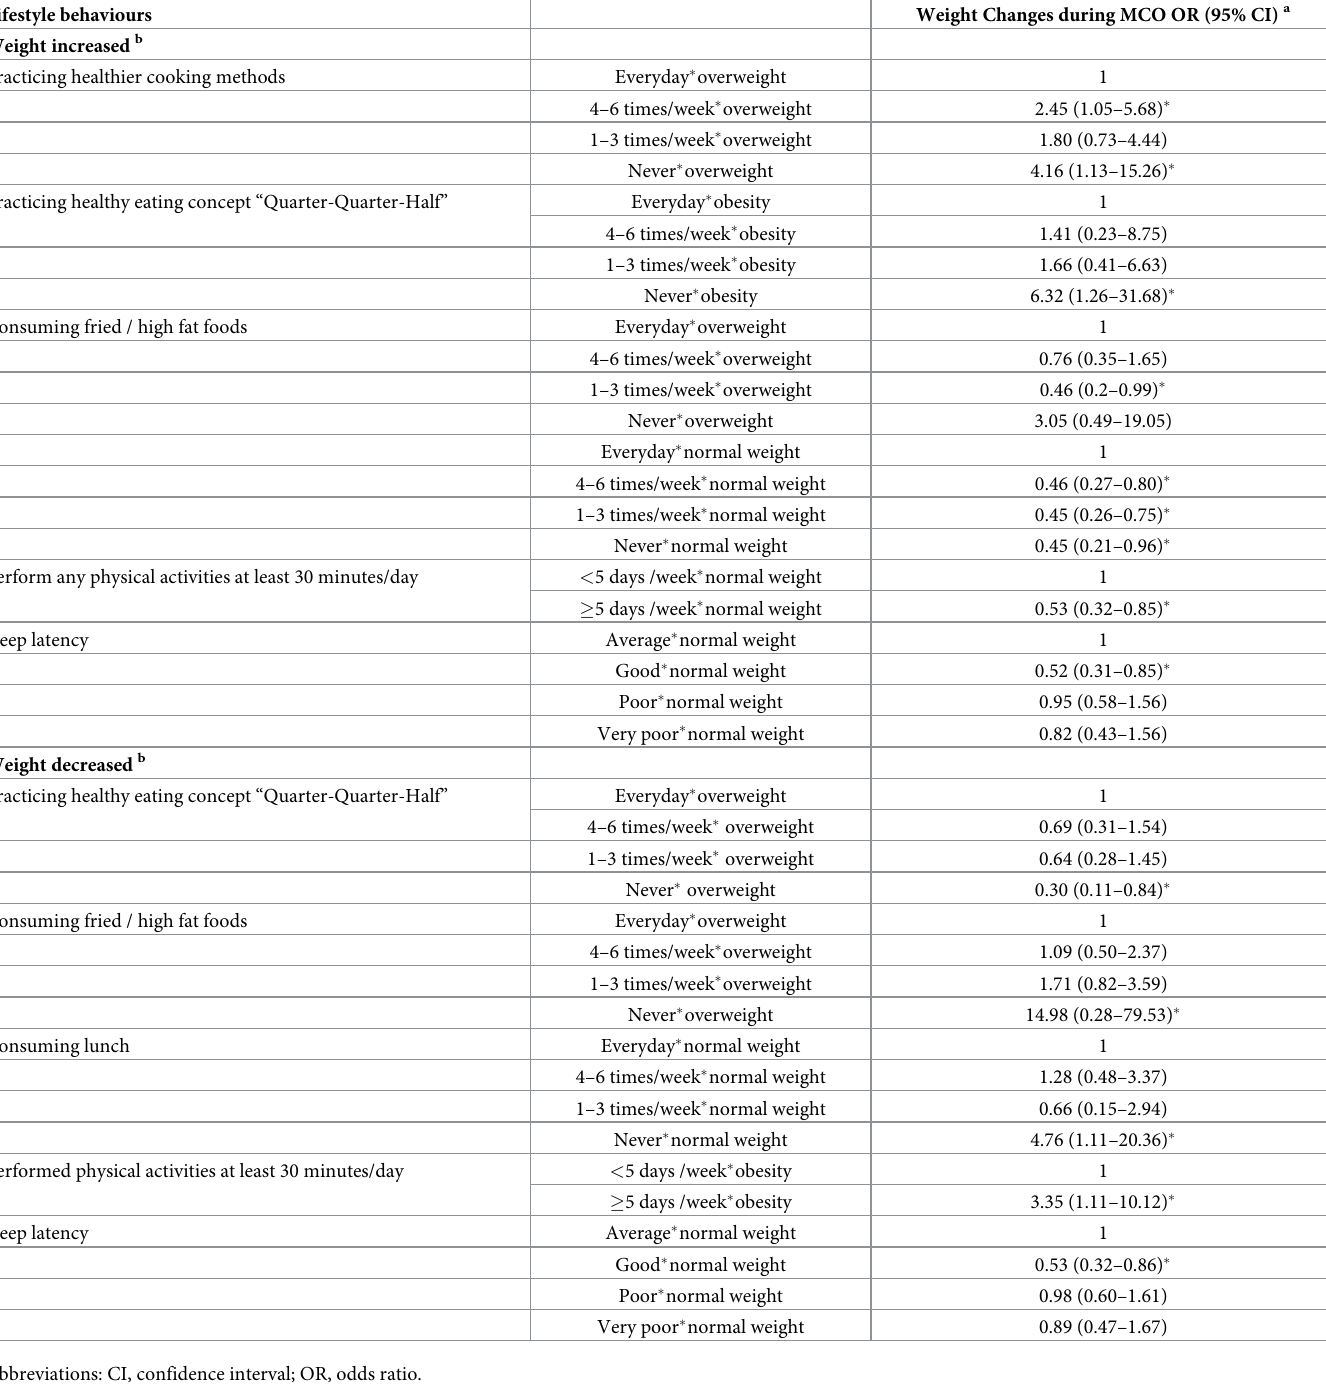
Table 5. Associations between lifestyle behaviours and body weight changes during MCO with interaction with BMI before